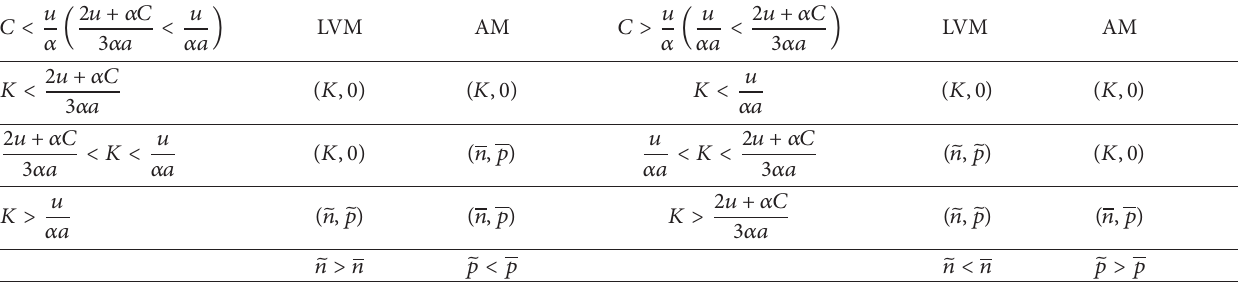
Table 1: The evolutionary stable state in LVM and